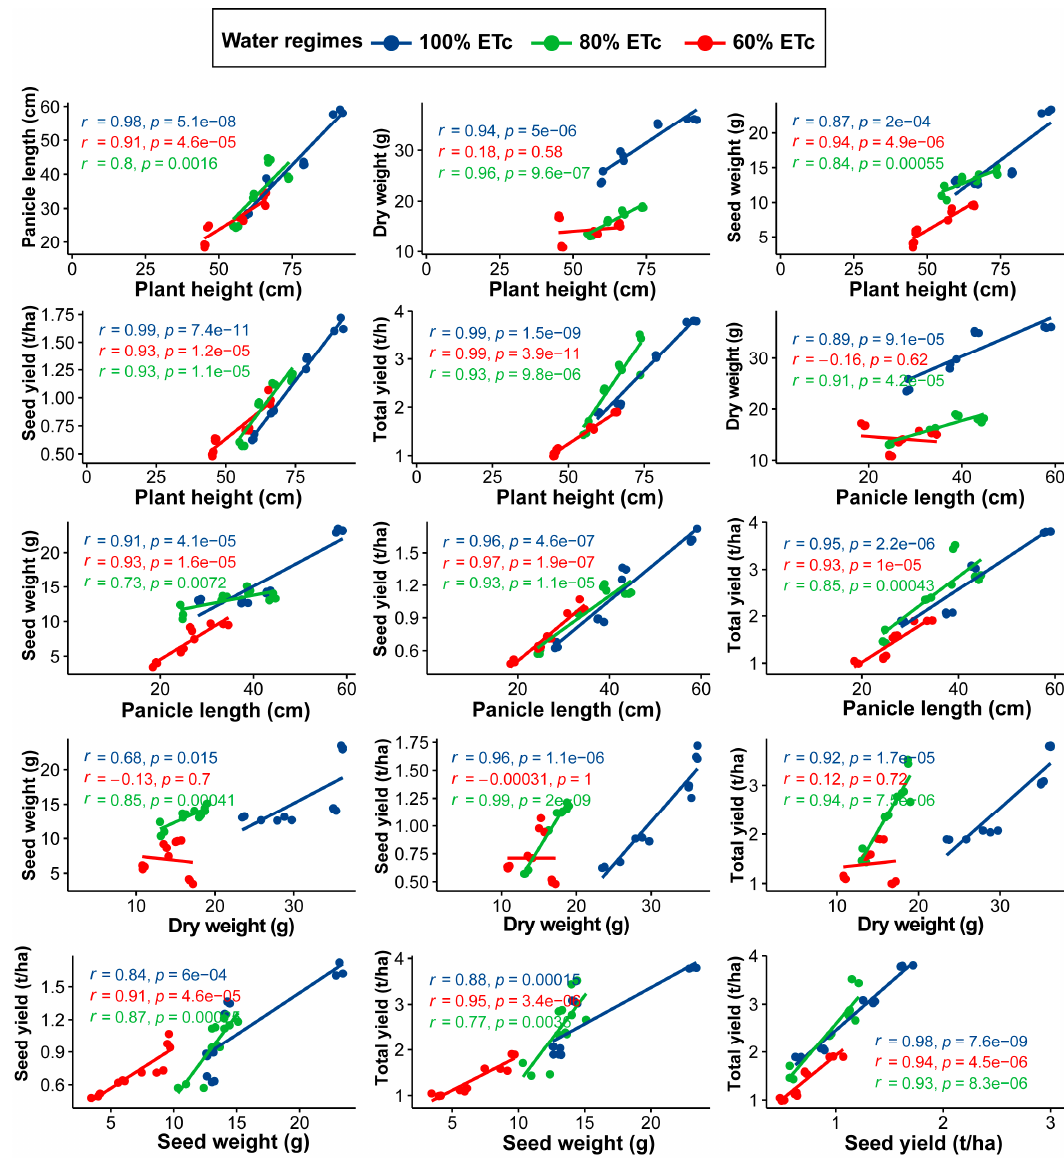
Figure 3. Scatter plot showing the pairwise relationships between six studied quinoa traits under three water regimes (60%, 80%, and 100% ETc) averaged over the two seasons of study at Arab El-Awammer Research Station. Correlation coefficients ( r ) and p -values are shown in the upper-left corner of the plot.